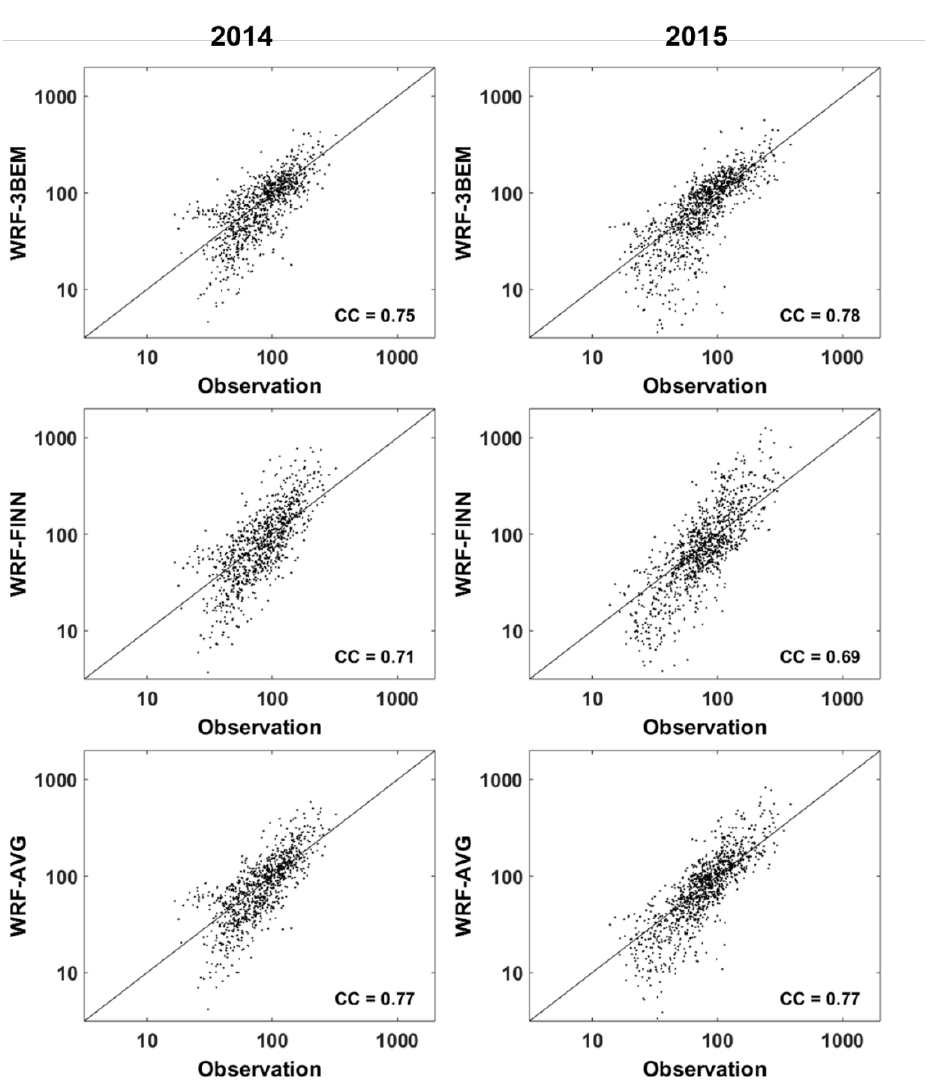
Figure 10. Scatter plots comparing measured daily average PM10 concentrations (μg m −3 ) and simulations of WRF-3BEM, WRF-FINN, and WRF-AVG for February–April 2014 and 2015 for all ground stations.